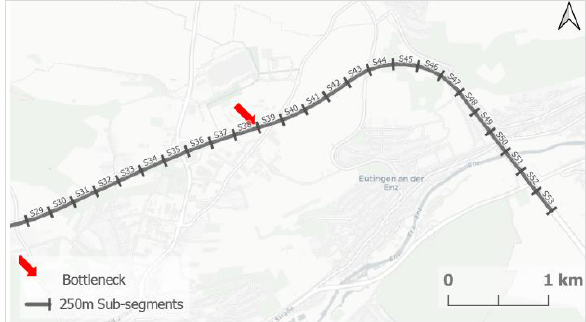
Figure 5: Subdividing the A8 highway section into virtual 250m